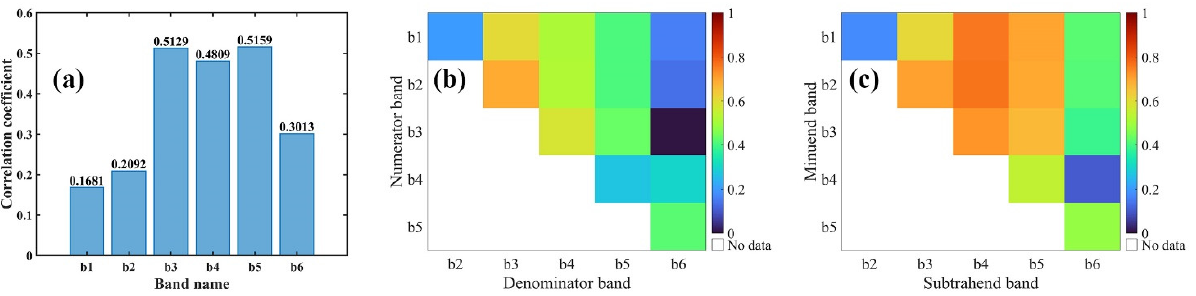
Figure 5. The correlation coefficient between water depth and ( a ) single band value from b1 to b6; ( b ) band ratio, where the vertical coordinate is the numerator band and the horizontal coordinate is the denominator band; ( c ) band difference, where the vertical coordinate is the minuend band and the horizontal coordinate is the subtrahend band.